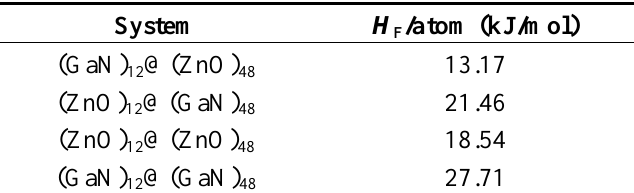
Table 6. Enthalpy of formation per atom of double bubble frameworks as defined in Equation